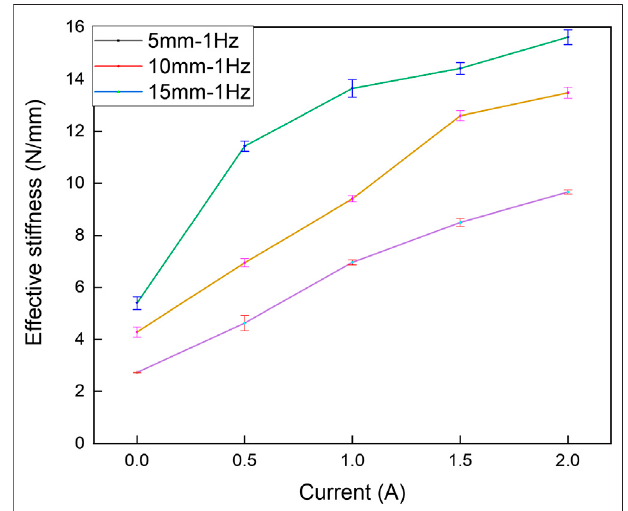
FIGURE 10 | The effective stiffness of the MR seat suspension applied with different